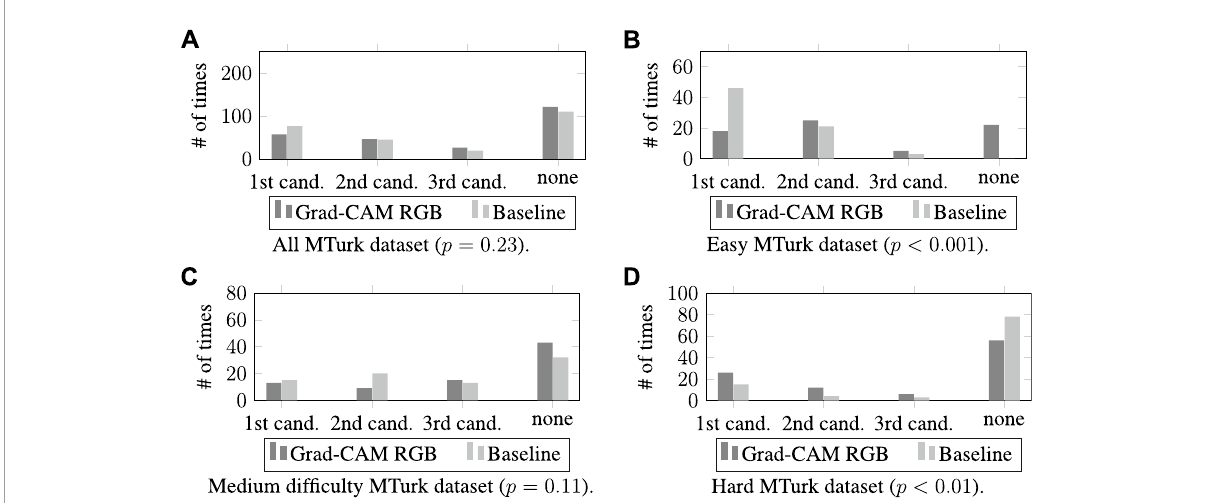
FIGURE 7 The number of times the Grad-CAM RGB method and the Mattnet baseline generated candidate bounding boxes that matched the target object by difficulty level. All MTurk Dataset in (A) , easy images in (B) , medium difficulty images in (C) , and hard images in (D)